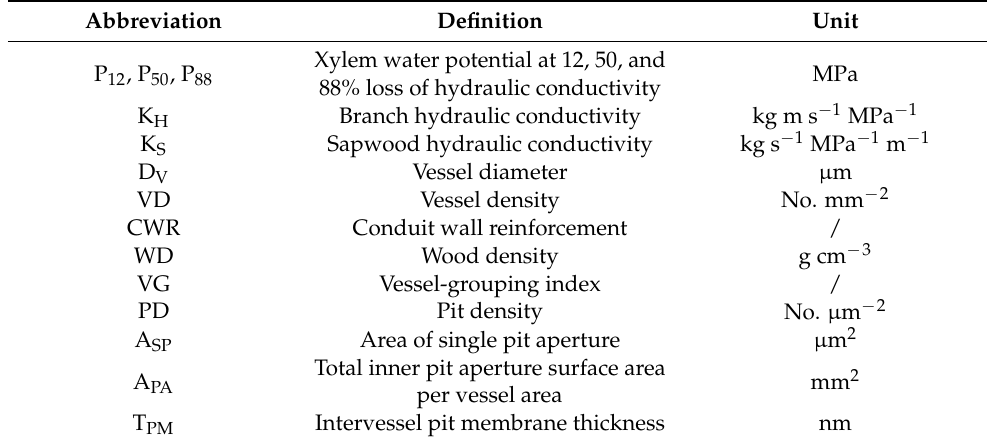
Table 1. List of traits included in the study with abbreviations, definitions, and